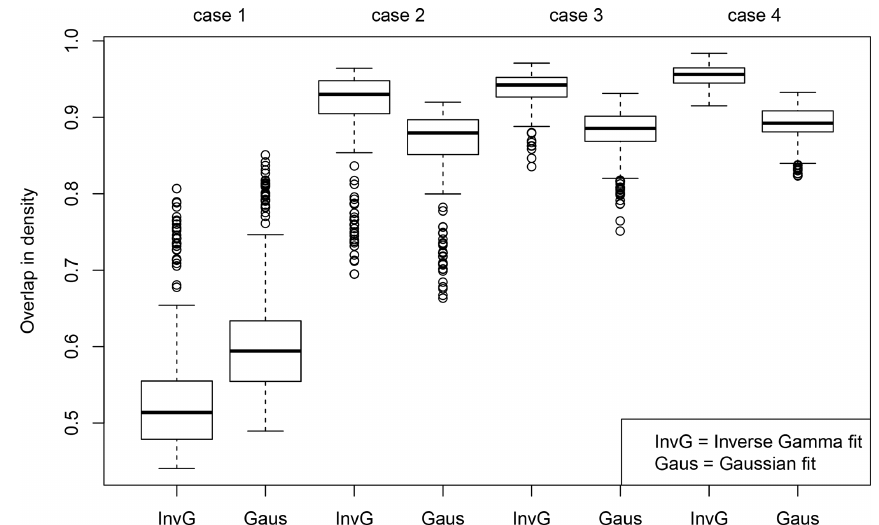
Figure 5. Box plots of the overlap between the ensemble densities and the fitted densities using uncertainty parameters obtained in four ways (cases 1 to 4; see Sect. 5.2 for details) and using the distribution in Eq. (5) (InvG) and the Gaussian distribution (Gaus) for